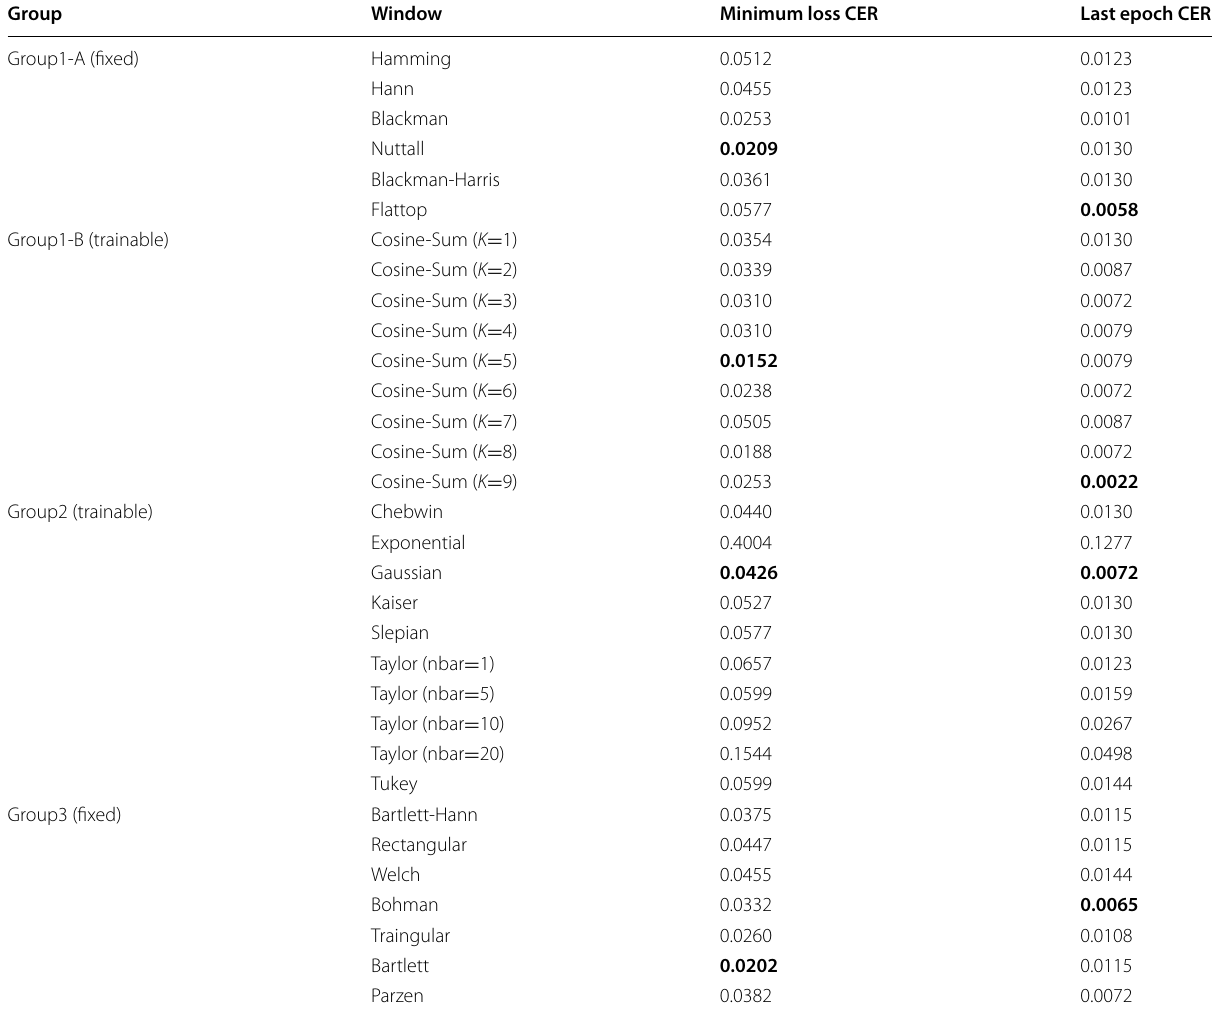
Table 4 Absolute sentence level CER for all the investigated window functions. Prominent results are highlighted and are also referred in Fig. 4b,